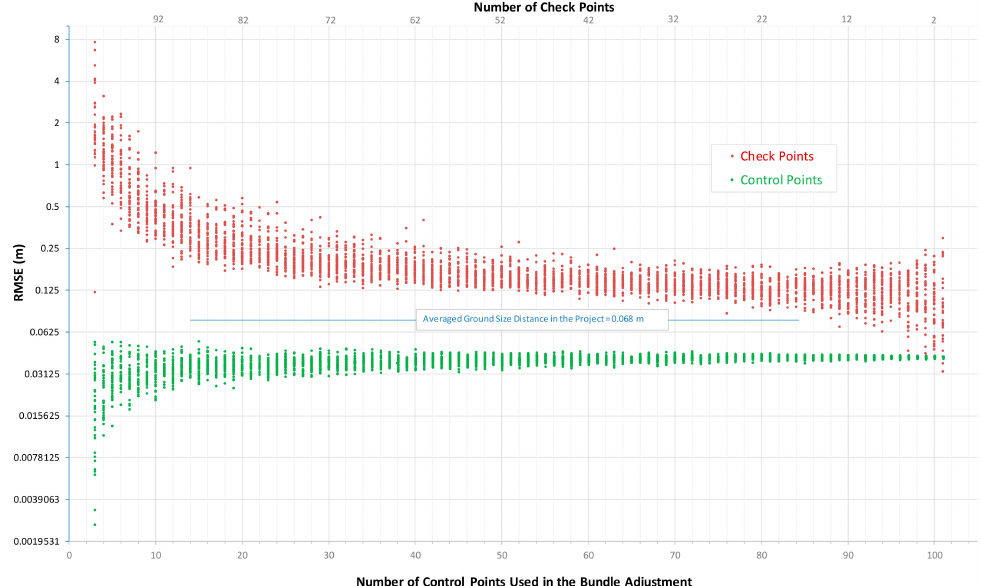
Figure 5. RMSE in control (green) and check (red) points in the 3465 data